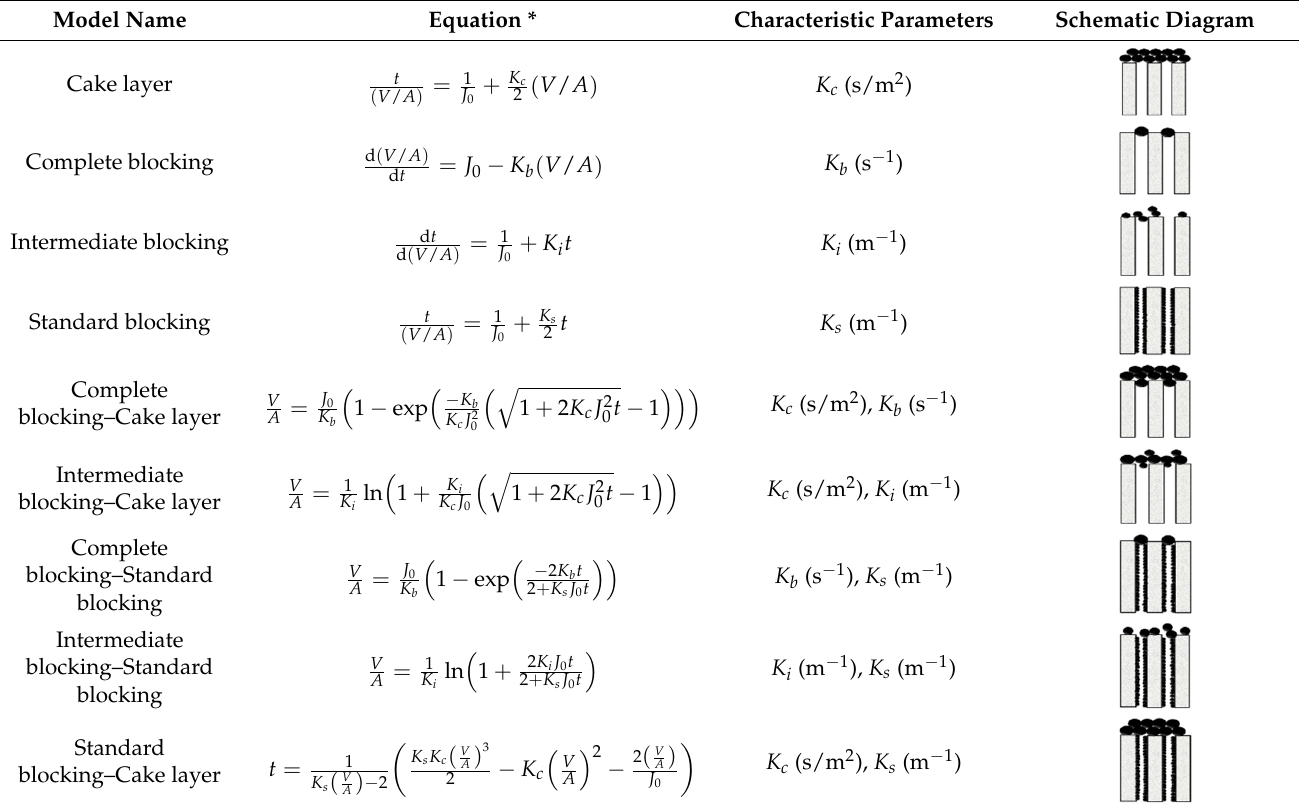
Table 1. Membrane fouling models for constant-pressure